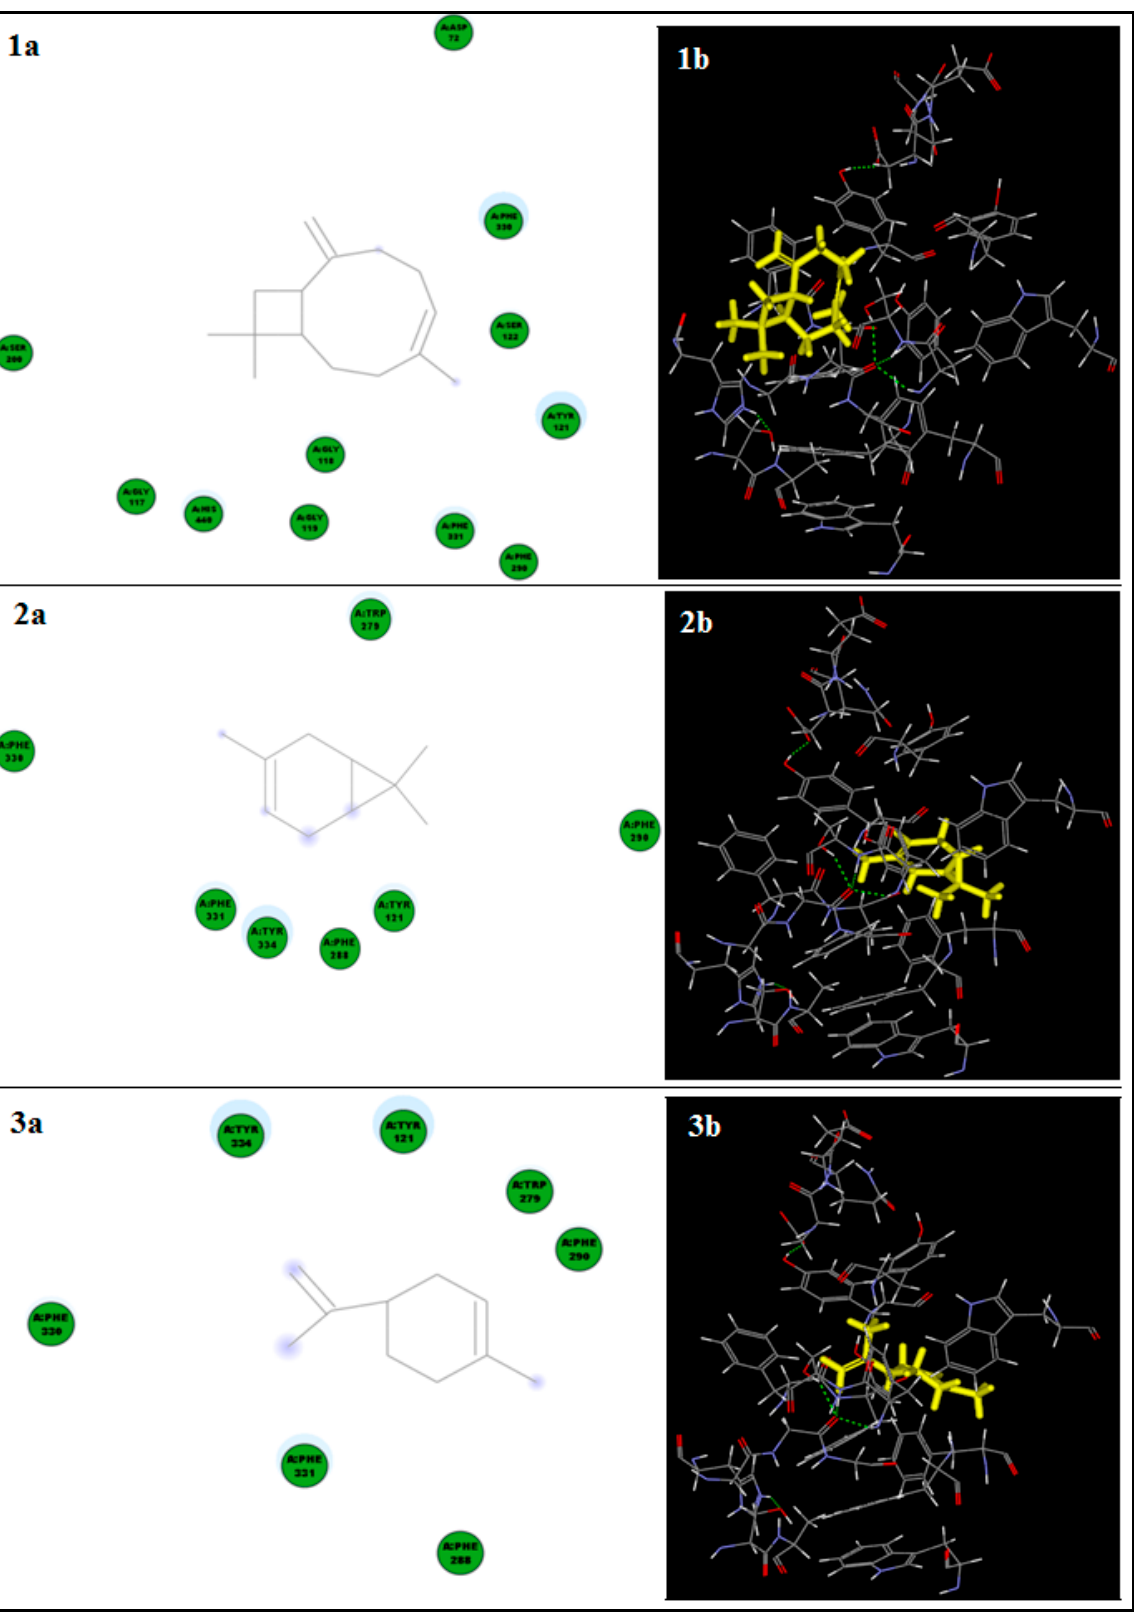
Figure 6. 2D-Binding ( a ) and 3D-binding ( b ) diagrams of β -caryophyllene ( 1 ), 3-carene ( 2 ), and limonene ( 3 ) to AChE crystal structure.